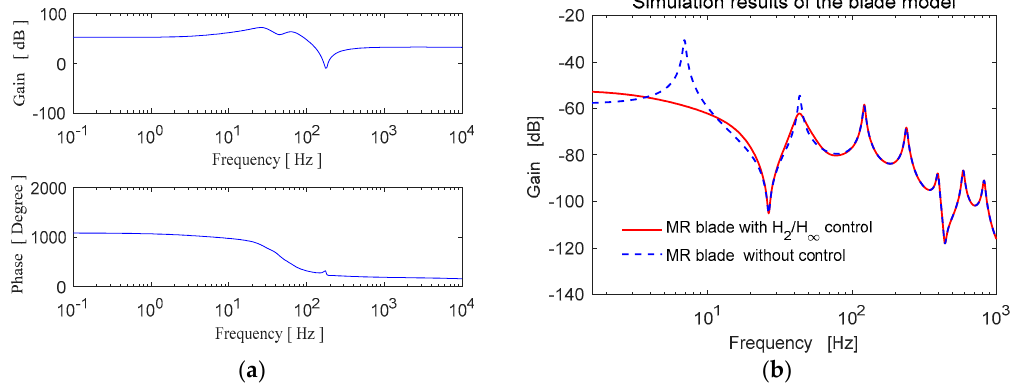
Figure 13. Frequency responses ( a ) the multi-objective controller, ( b ) the closed-loop system.